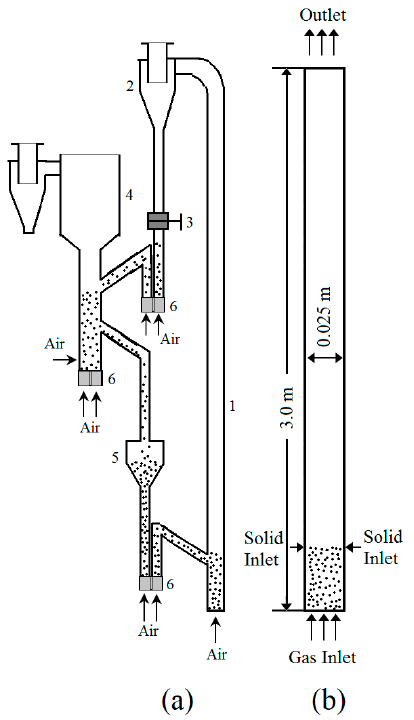
Table 1. System geometry, gas and solid phase properties and flow condition.